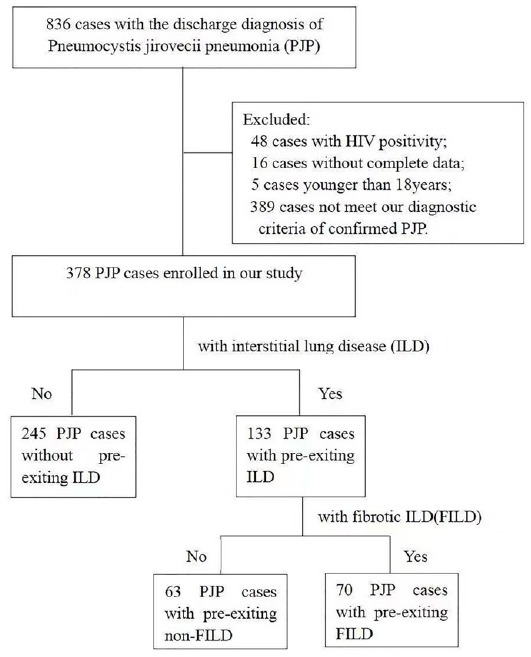
Figure 2. The study flow chart.